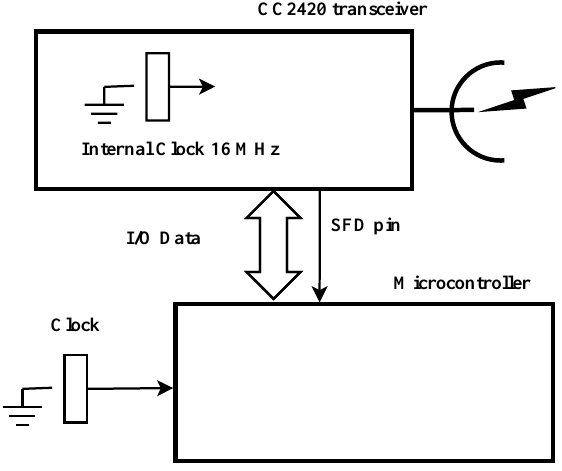
Figure 3. Detail of the TI CC2420 transceiver connected to the microcontroller.